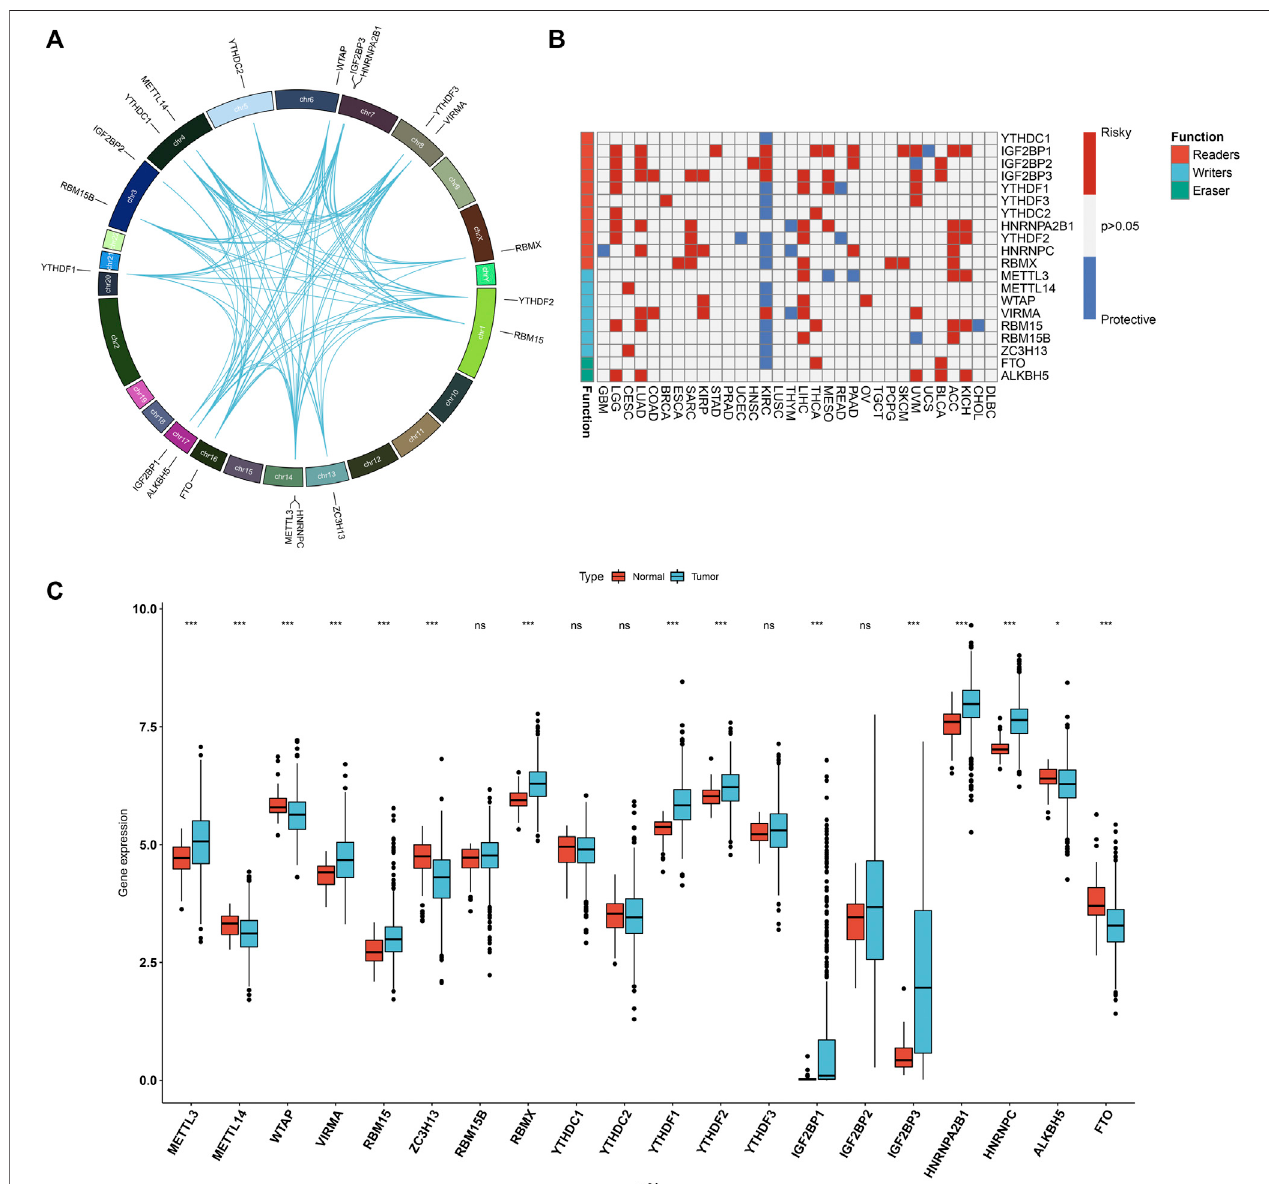
FIGURE 1 | Landscape of expression patterns and prognostic value of 20 m 6 A regulators in LUAD. (A) The location of 20 m 6 A regulators on the human chromosomes. Lines in circle represented their interactions according to the STRING database. (B) Heatmap showing the correlations between m 6 A regulators and prognosis of pan-cancer in TCGA cohorts. The left side of the heatmap showed the functions (writer, eraser and reader) of m 6 A regulators. Red indicated that a speci fi c regulator was a risk factor for a type of cancer and blue indicated that a speci fi c regulator was a protective factor for a type of cancer. (C) Comparison of the expression of m 6 A regulators between LUAD and normal tissues in the TCGA dataset with Wilcoxon test. Ns: not signi fi cant; * p < 0.05; *** p <